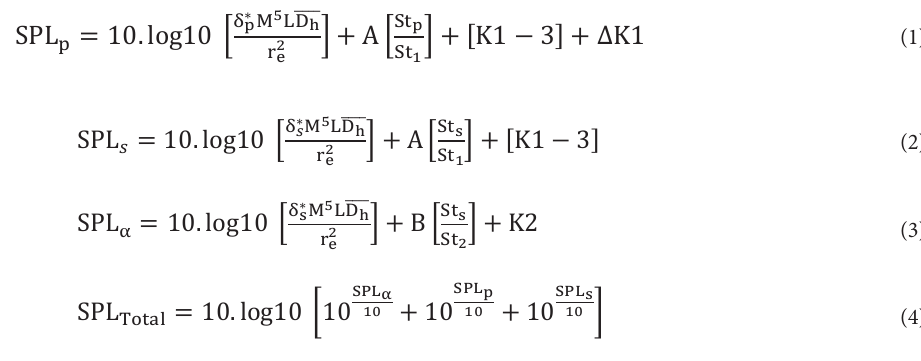
The turbulent boundary layer noise occurs on both suction and pressure sides of aerofoil and is considered as common source of noise from wind turbine blade. In this type of source the thickness of turbulent boundary layer, δ, local Mach number, M, and , are important parameters to predict the length of blade segment, L, as well as the distance between the observer and source, r e acoustic field from 2D surfaces (Brooks et al. 1989). Equations 1 and 2 are used to calculate the sound pressure levels involving spectral functions, while Eq. 3 is used for angle dependent noise source (Zhu 2005; Dijkstra 2015; Brooks et al. 1989; Moriarty and Migliore 2001), which is caused at moderate to high angle of attack (AOA). Noise is produced due to interaction of incident hydrodynamic pressure field with trailing edge surface of an aerofoil. The phenomenon of resistance to the motion of sound waves from a rigid surface is termed acoustic impedance. The sound pressure levels from this source are obtained by adding the components of noise source along the blade length on both the pressure and suction sides and given by Eq. 4.